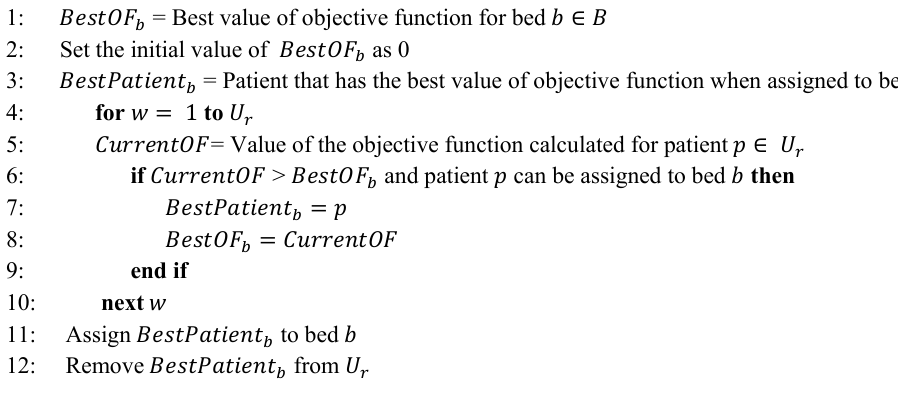
Algorithm 2. Pseudocode for assigning the best-suited patient for bed 𝑏 ∈